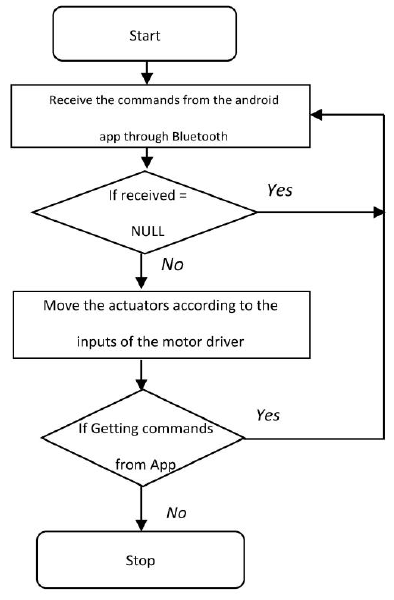
Figure 1. Motion of the tele-operated master robot.